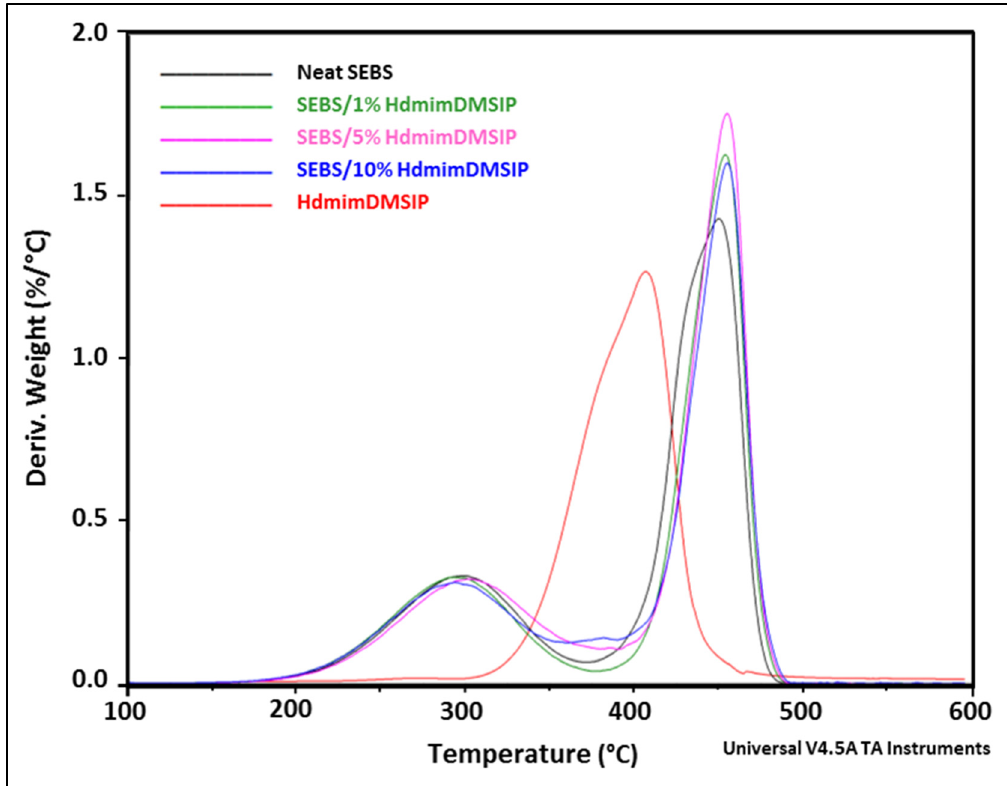
Figure 6. DTG curves of the IL HdmimDMSIP, neat SEBS, and SEBS/IL blends.